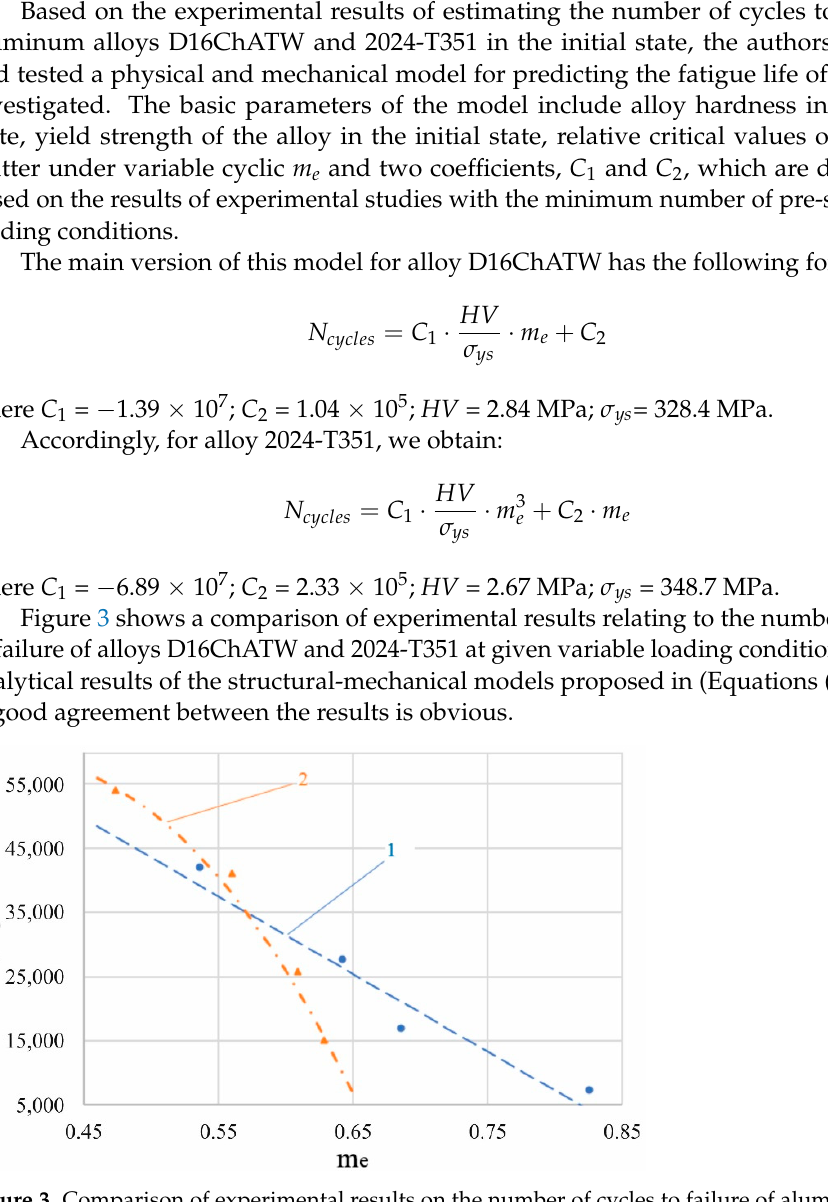
Figure 3. Comparison of experimental results on the number of cycles to failure of aluminum alloys in the initial state (D16ChATW (blue dots); 2024-T351 (red triangles)) at given variable loading conditions (m е parameter) with analytical results of the structural and mechanical models proposed (dashed line 1, Equation (3); dashed curve 2, Equation (4)).